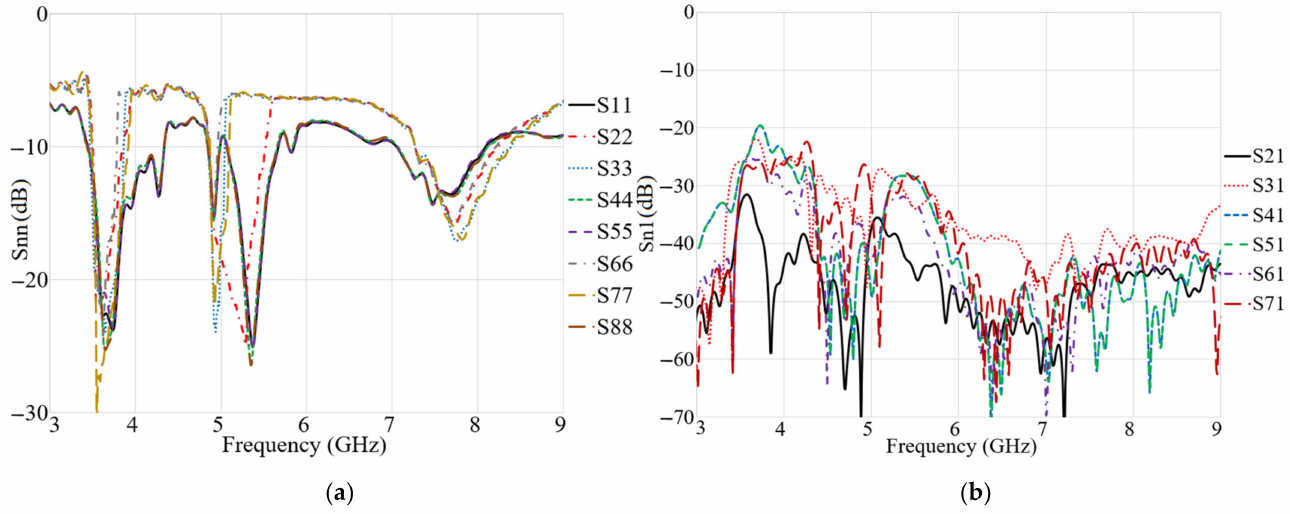
Figure 18. The simulated: ( a ) reflection and ( b ) transmission coefficient results of the MIMO antenna for a handset structure. Figure 19 indicates the experimental results for reflection and transmission coefficients attained by the handset MIMO using a board with a similar size to a smartphone. It depicts that the MIMO antenna works well at the frequencies of 3.8 GHz, 5.2–5.4 GHz, and 5.8